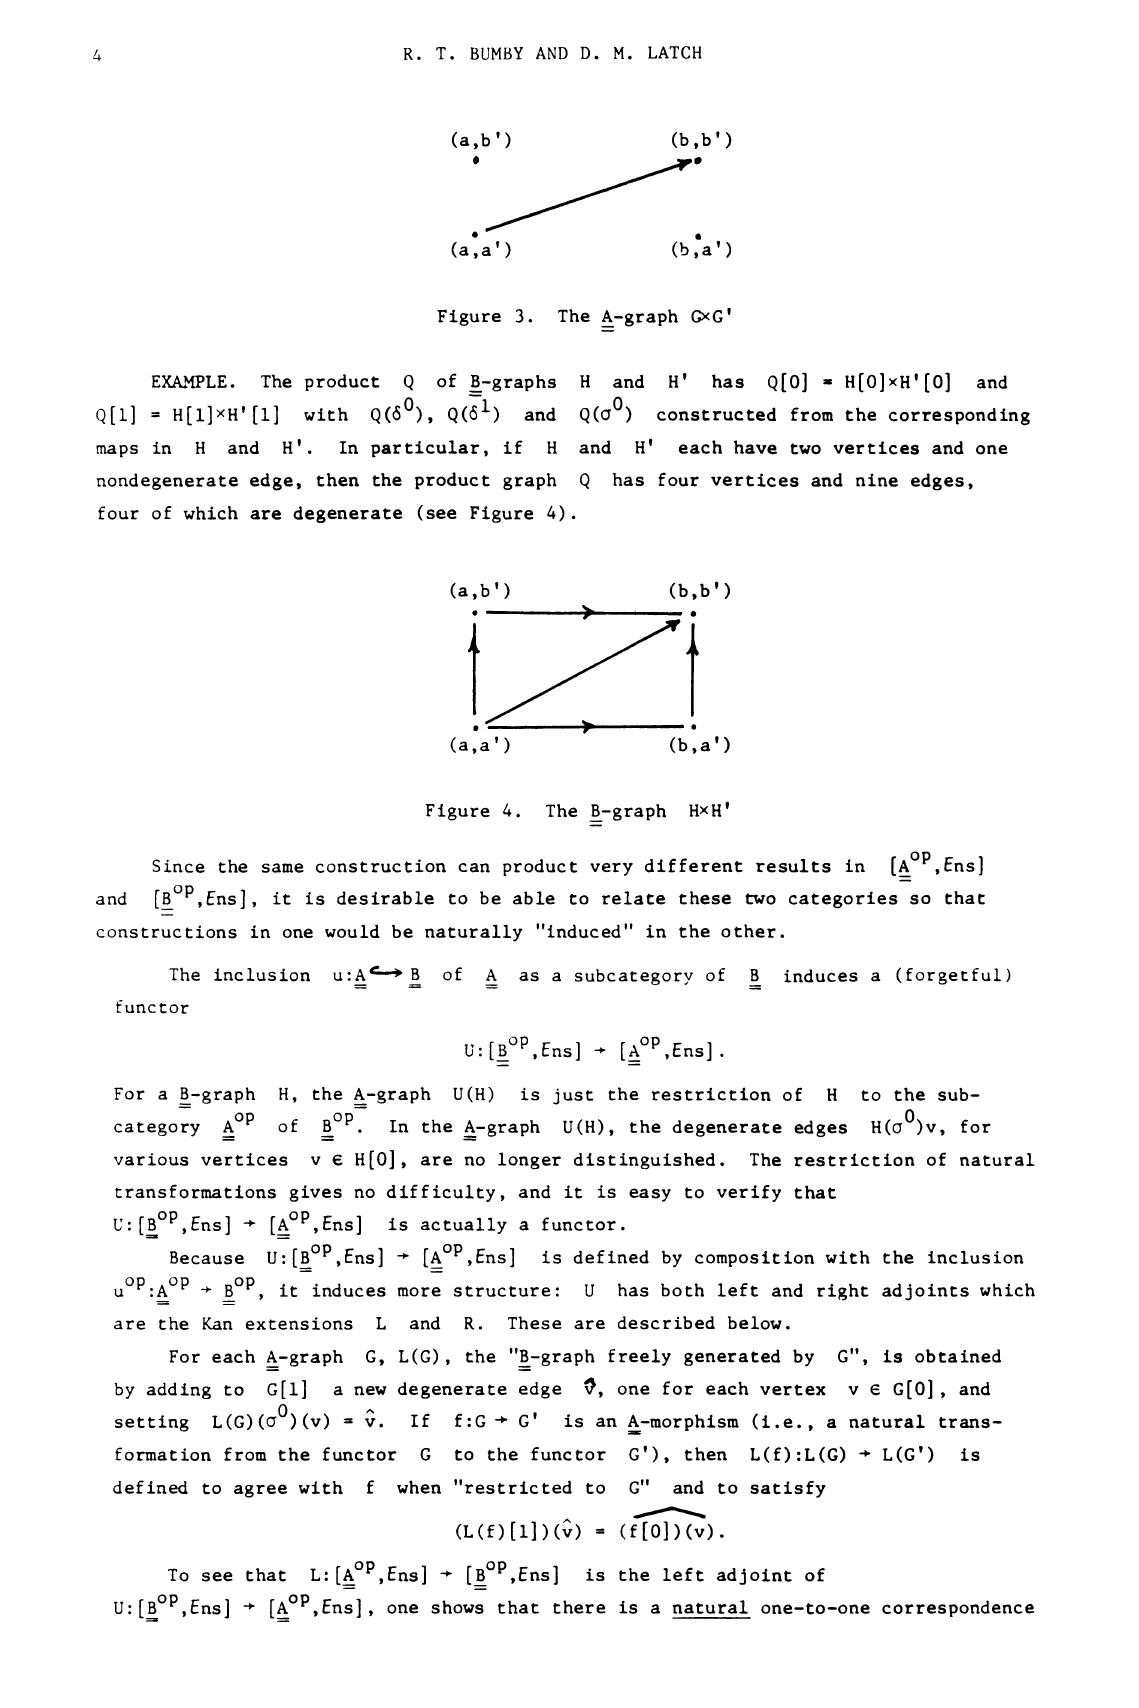
Figure 4. The B_-graph